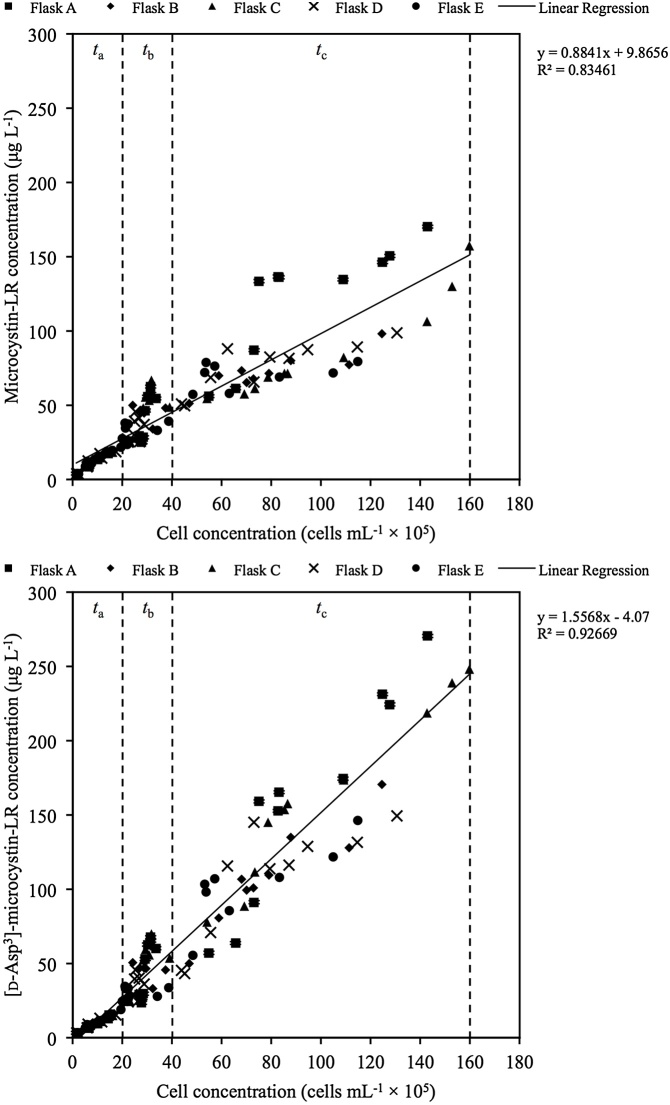
Detectable microcystin-LR (top) and [D-Asp3]-microcystin-LR (bottom) over cell concentrations in five experimental cultures of Microcystis aeruginosa CPCC 300 since time of inoculation. The microcystin cell quota (Qmcyst) increases above and decreases below the linear regression line. ta = days 0–11; tb = days 12–21; tc = days 25–46.